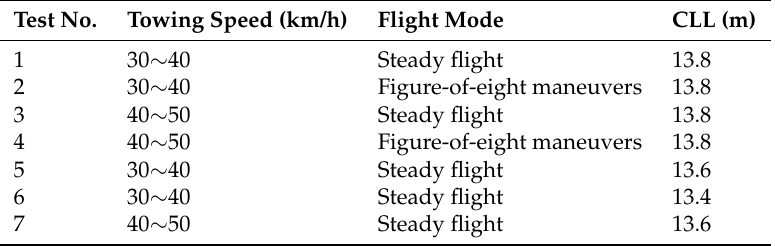
Table 2. Test specifications based on truck speed, flight mode and control line length